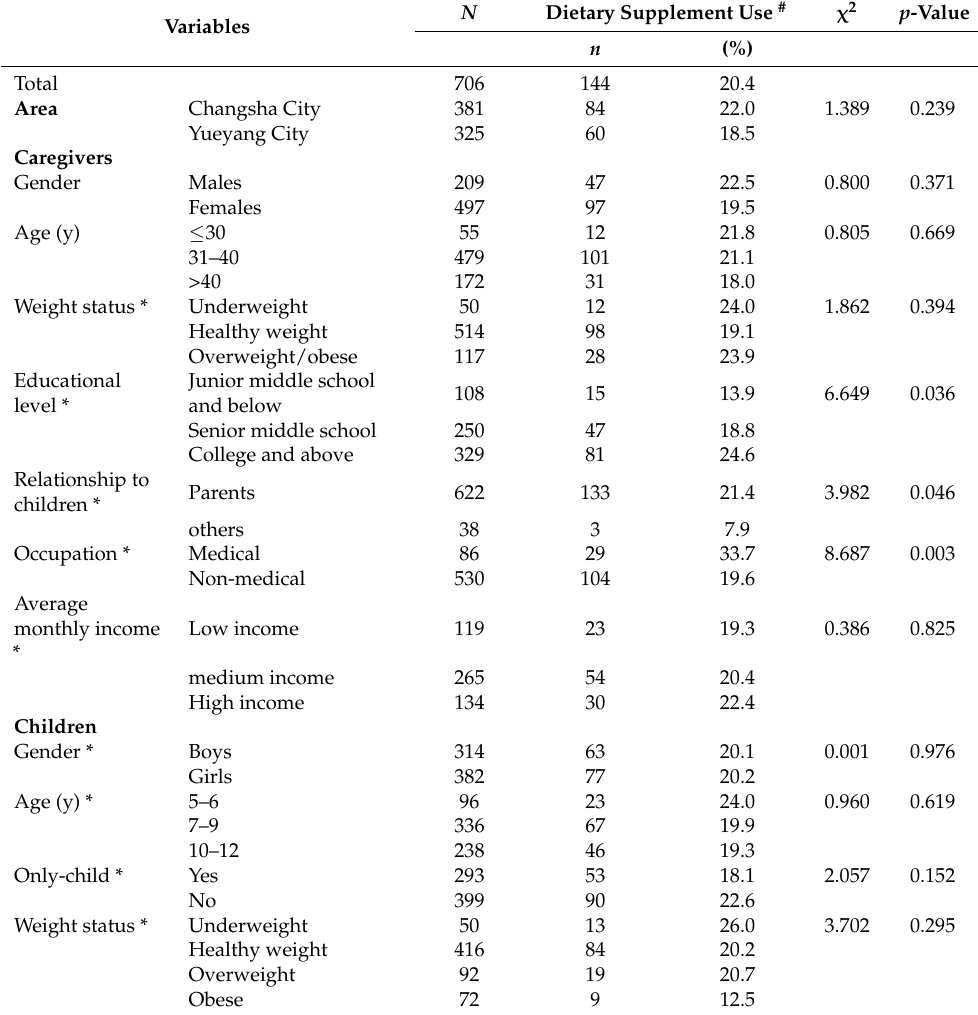
Table 1. Dietary supplement use among primary school students by demographic